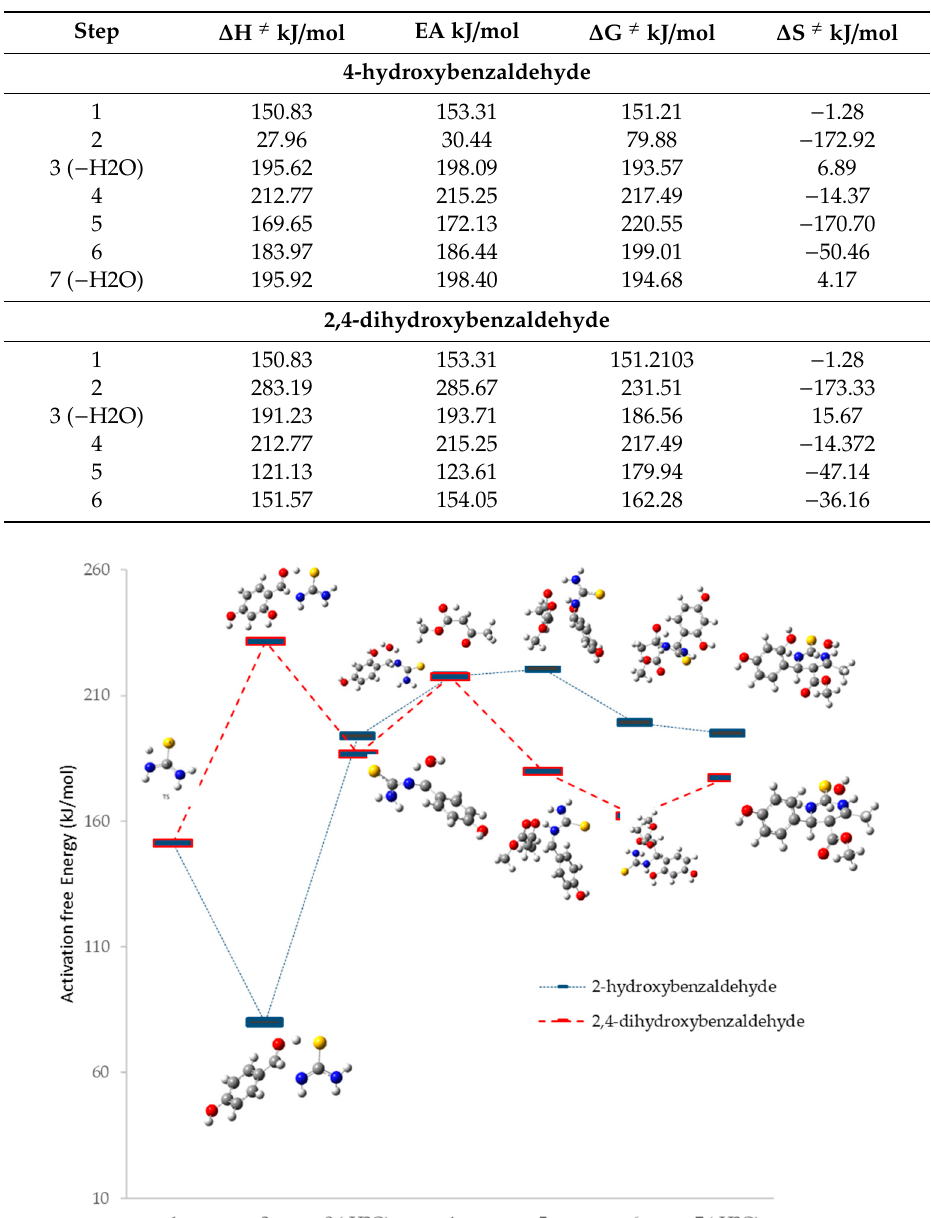
Table 2. Kinetic and thermodynamic activation energies obtained in each stage of the Biginelli reaction, studied at the B3LYP / 6-31 ++ G(2d,p) level of theory for 4-hydroxybenzaldehyde and 2,4-dihydroxybenzaldehyde.